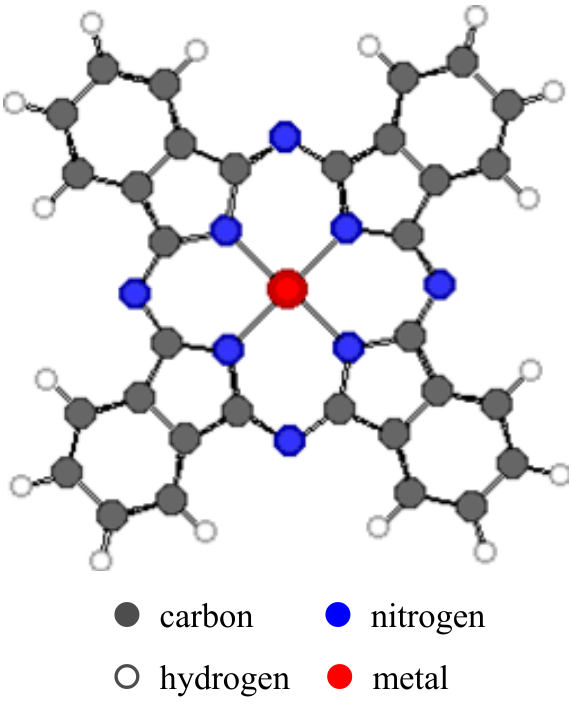
Figure 1. Structure of